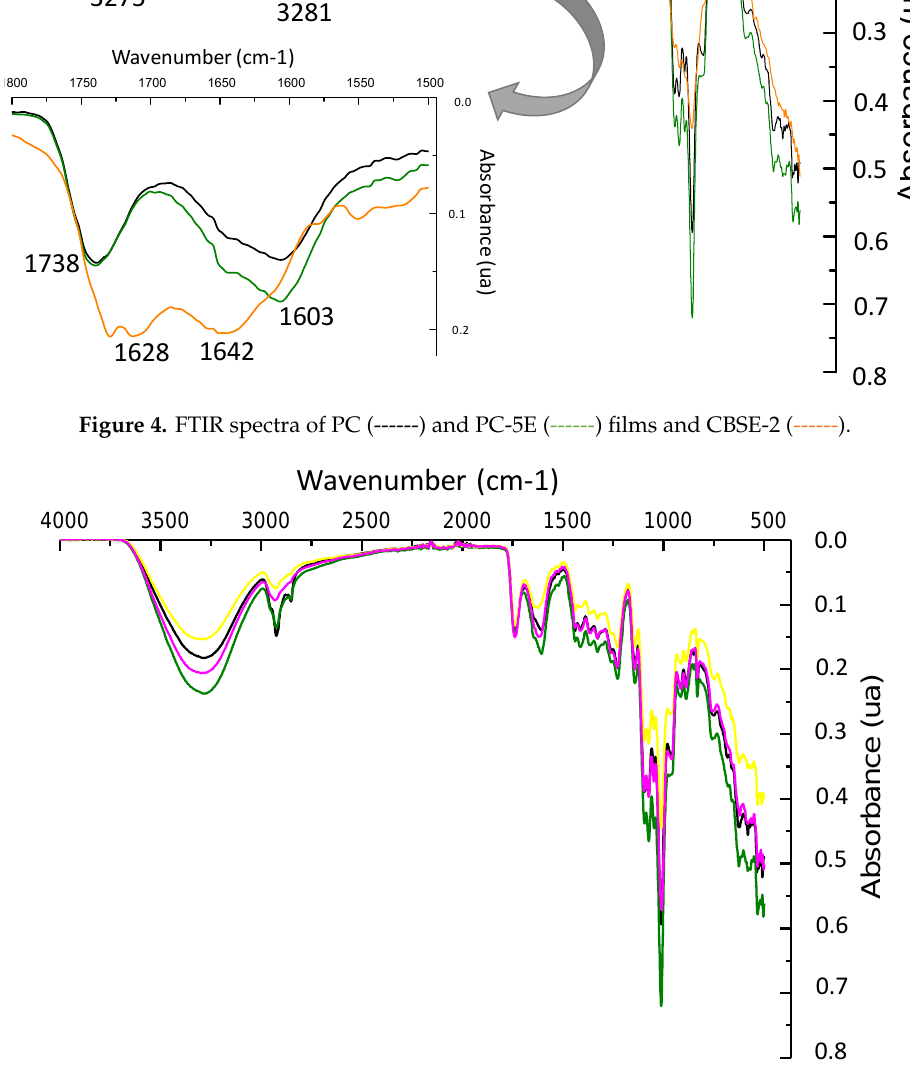
Figure 5. FTIR spectra of PC (------), PC-5E (------), PC-5E-1ZnO (------) and PC-5E-3ZnO (------) films.